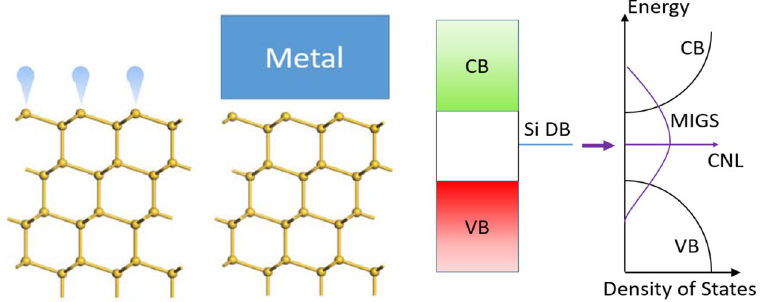
Figure 6. ( a ) Schematic of (111) Si surface, showing Si dangling bonds, ( b ) Si/metal interface, ( c ) schematic band diagram with the Si dangling bond states having broadened into MIGS.